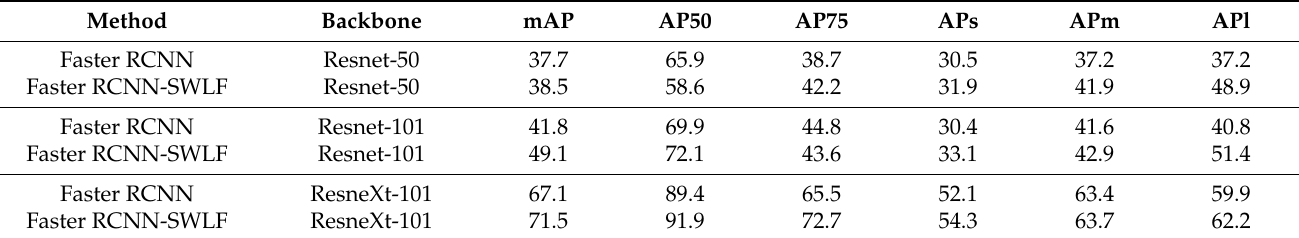
Table 8. Ablation Studies of Sample Weighted Loss